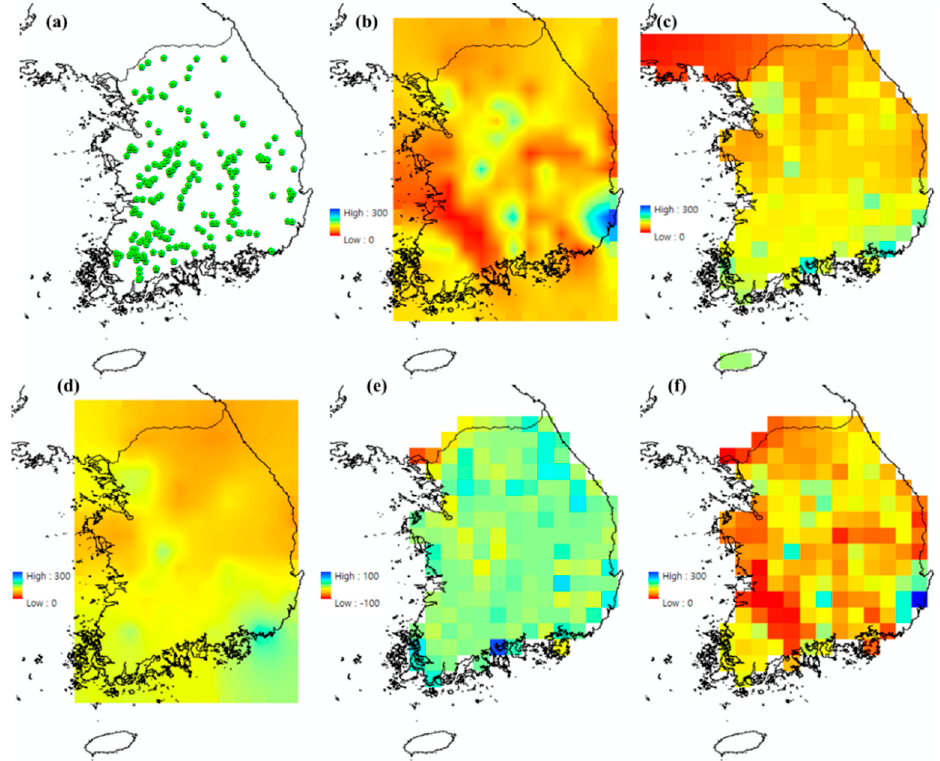
Figure 4. Flow chart of the conditional merging method. IDW: inverse distance weighting.